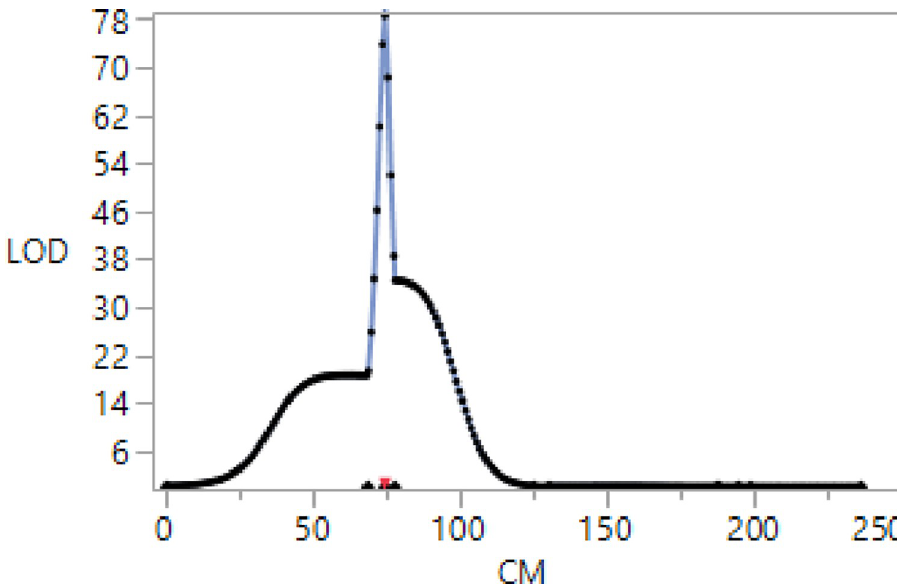
Fig 3. LOD profile generated for field response to crown rust infection from a Pc54 × Pc96 F5-derived oat population on chromosome 7D where each SNP marker is represented by a single